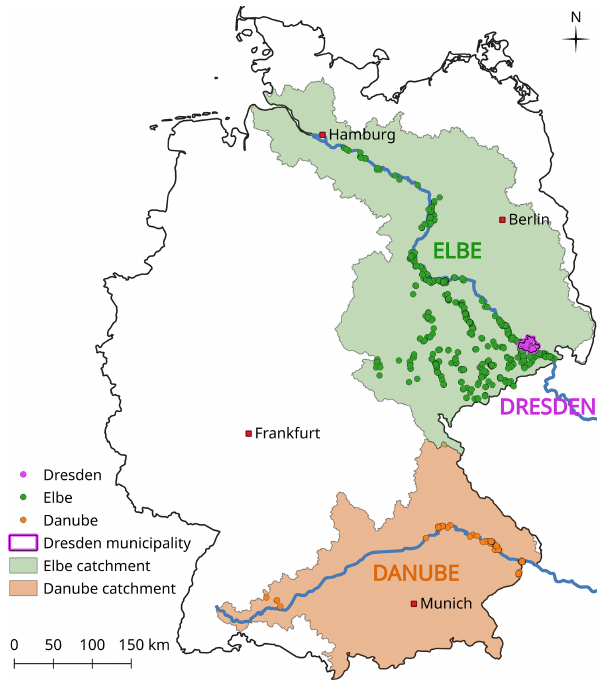
Figure 1. Regional subdivision of the data set for spatial split- sample testing (Dresden municipality, the Elbe catchment and the Danube